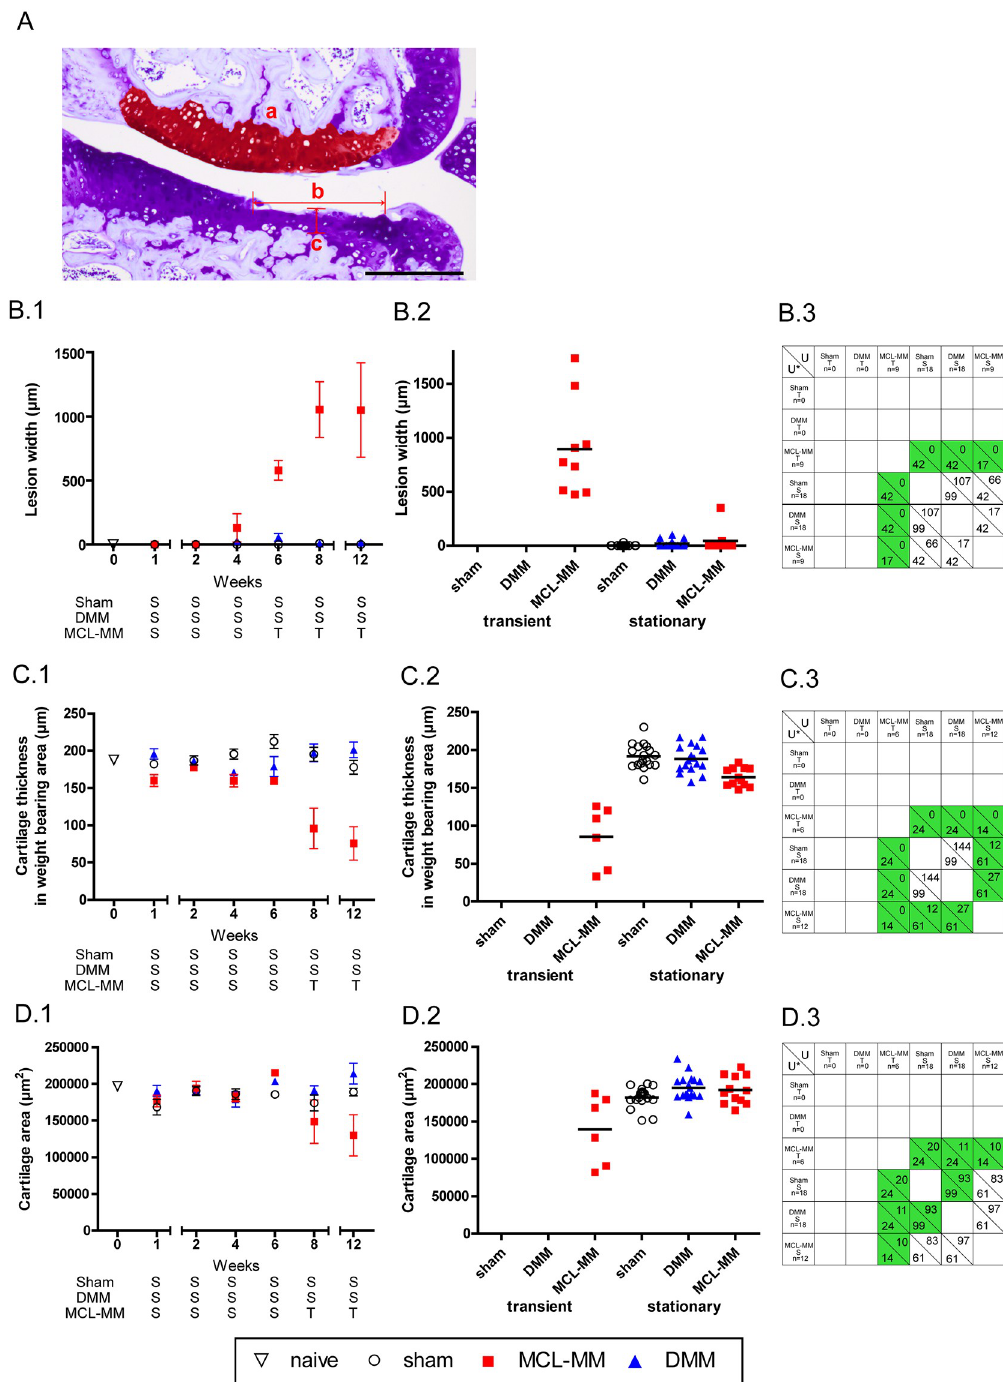
Fig 3. Assessment of progressing joint destruction on the basis of measurements on serial (A) TB stained joint sections of B) lesion width (b), C) cartilage thickness (c), D) cartilage area (a), B.1-D.1). The time course (mean ± SEM) of the studied effects (lesion width, cartilage thickness, cartilage area) in the surgical OA models of interest (sham, DMM, MCL-MM). The trend analysis for the classification of time points into stationary (S) and transient (T) phases is given in S1 Methods. Lesion width in surgical OA models aggregated into phases: sham (T) (none), DMM (T) (none), MCL-MM (T) (wks 6–12), sham (S) (wks 1–12), DMM (S) (wks 1–12), MCL-MM (S) (wks 1–4). C.2) Cartilage thickness in surgical OA models aggregated into phases: sham (T) (none), DMM (T) (none), MCL-MM (T) (wks 8,12), sham (S) (wks 1–12), DMM (S) (wks 1–12), MCL-MM (S) (wks 1–6). D.2) Cartilage area in surgical OA models aggregated into phases: sham (T) (none), DMM